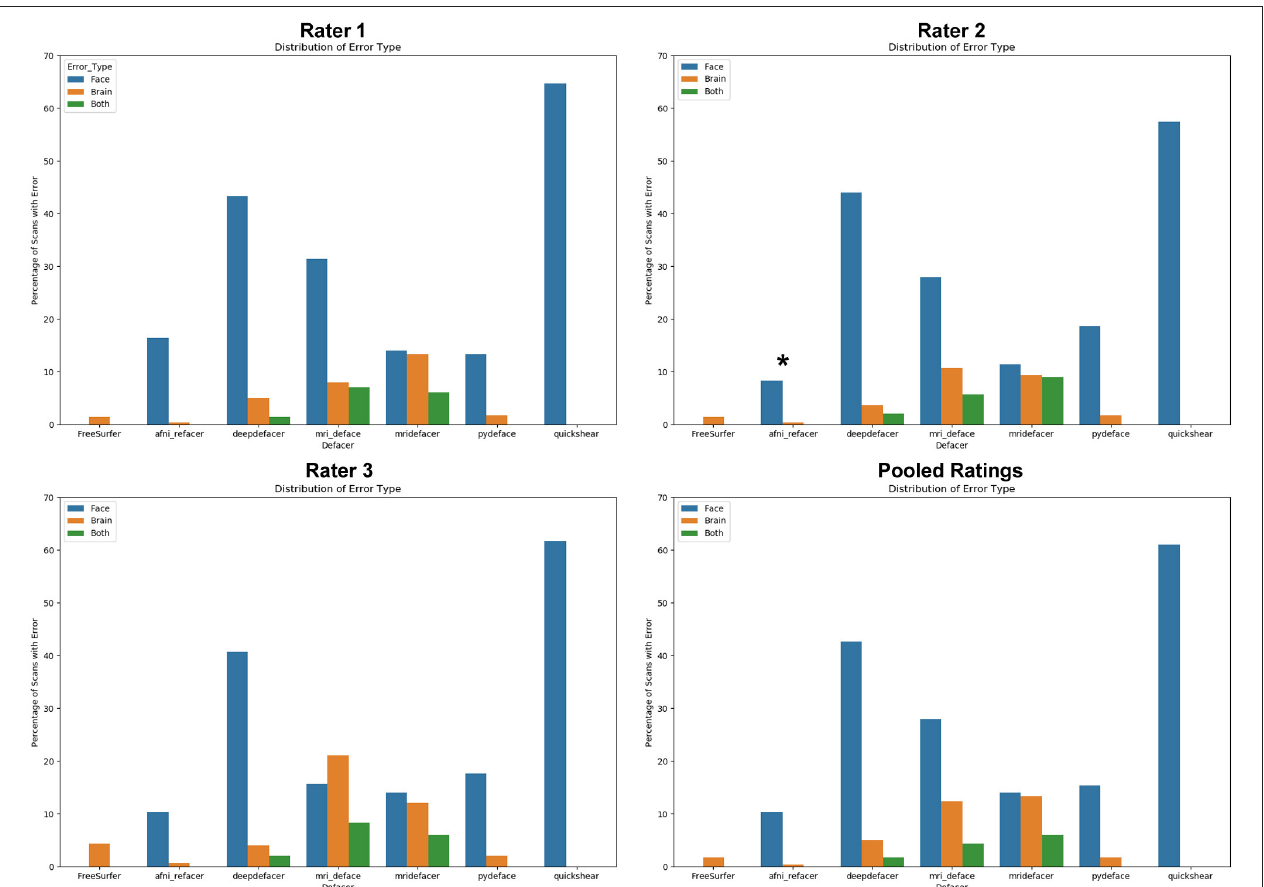
FIGURE 3 | Percentage of scans where errors were detected for each of the seven algorithms, split based on error class. “Face” refers to scans that were failed due to at least one identifiable facial feature (eyes, nose, mouth) remaining after defacing, “brain” refers to scans that were failed due to the algorithm removing neuronal tissue, while “both” references scans where both of these errors occurred. Pooled ratings were calculated from the rater consensus for each scan. *Disclaimer: afni_refacer_run ratings had to be redone due to a major software update after initial data collection. Due to the unavailability of the original Rater 2, these ratings were completed by a different